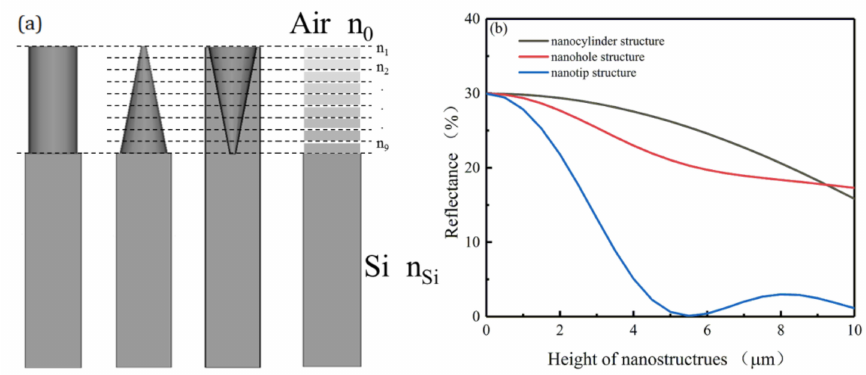
Figure 7. ( a ) The graded index layer model of nanocylinder, nanotip, and nanohole structures. ( b ) The calculated reflectance of the THz waves (2 THz) of nanostructures with di ff erent